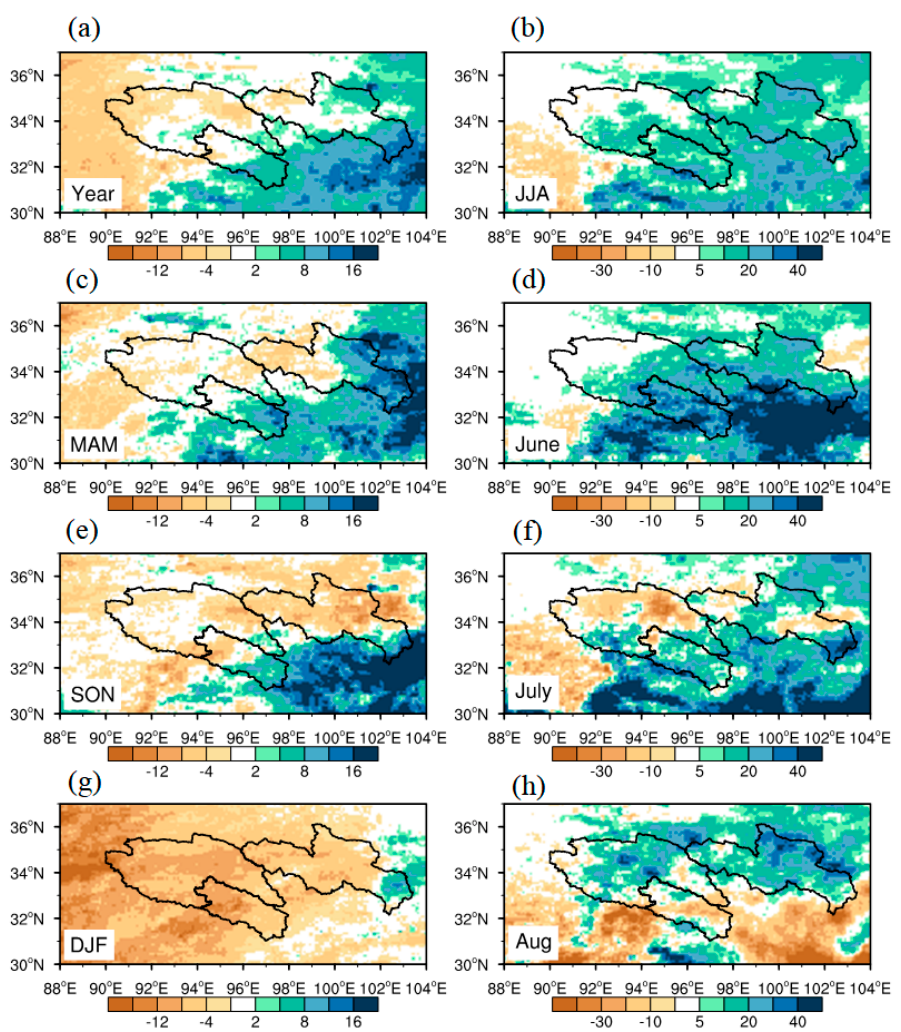
Figure 5. Difference between precipitation ( a ) annual average, ( b ) June-July-August (JJA) average, ( c ) March-April-May (MAM) average, ( d ) June average, ( e ) September-October-November (SON) average, ( f ) July average, ( g ) December-January-Februrary (DJF) average, and ( h ) August average from 2010 to 2019 and from 2001 to 2010